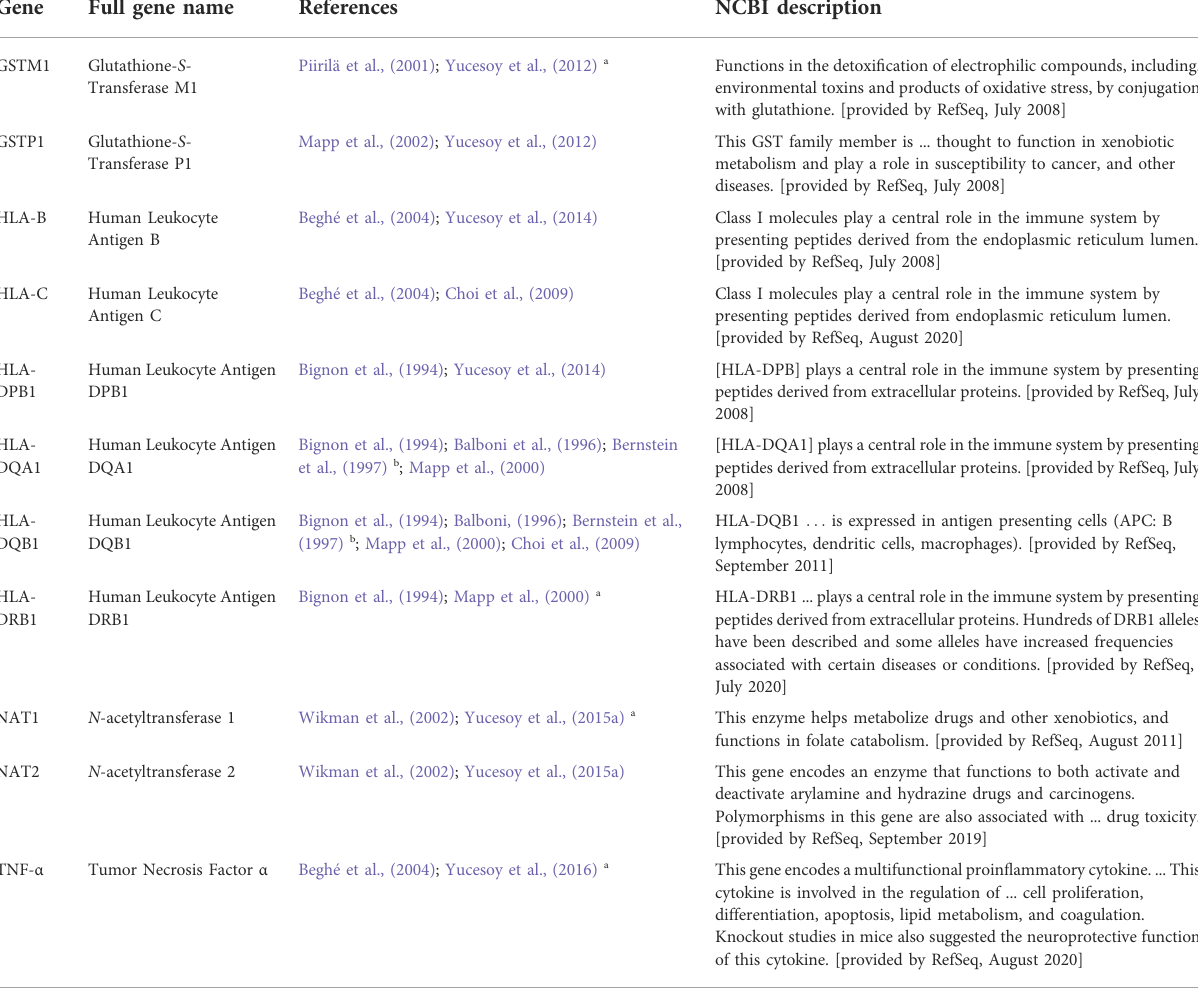
TABLE 2 Descriptions of genes that were included in the meta-analysis because two to three manuscripts reported markers within those genes with signi fi cantdiisocyanate-asthma(DA)associations.Geneticmarkersthatweresigni fi cantonlyincombinationwithoneormoreothermarkersasa haplotype are not listed here. The genes in this table were reported to be associated with DA when genetics of workers with DA were compared to asymptomatic workers (AW) or unexposed healthy normal individuals (NC) as